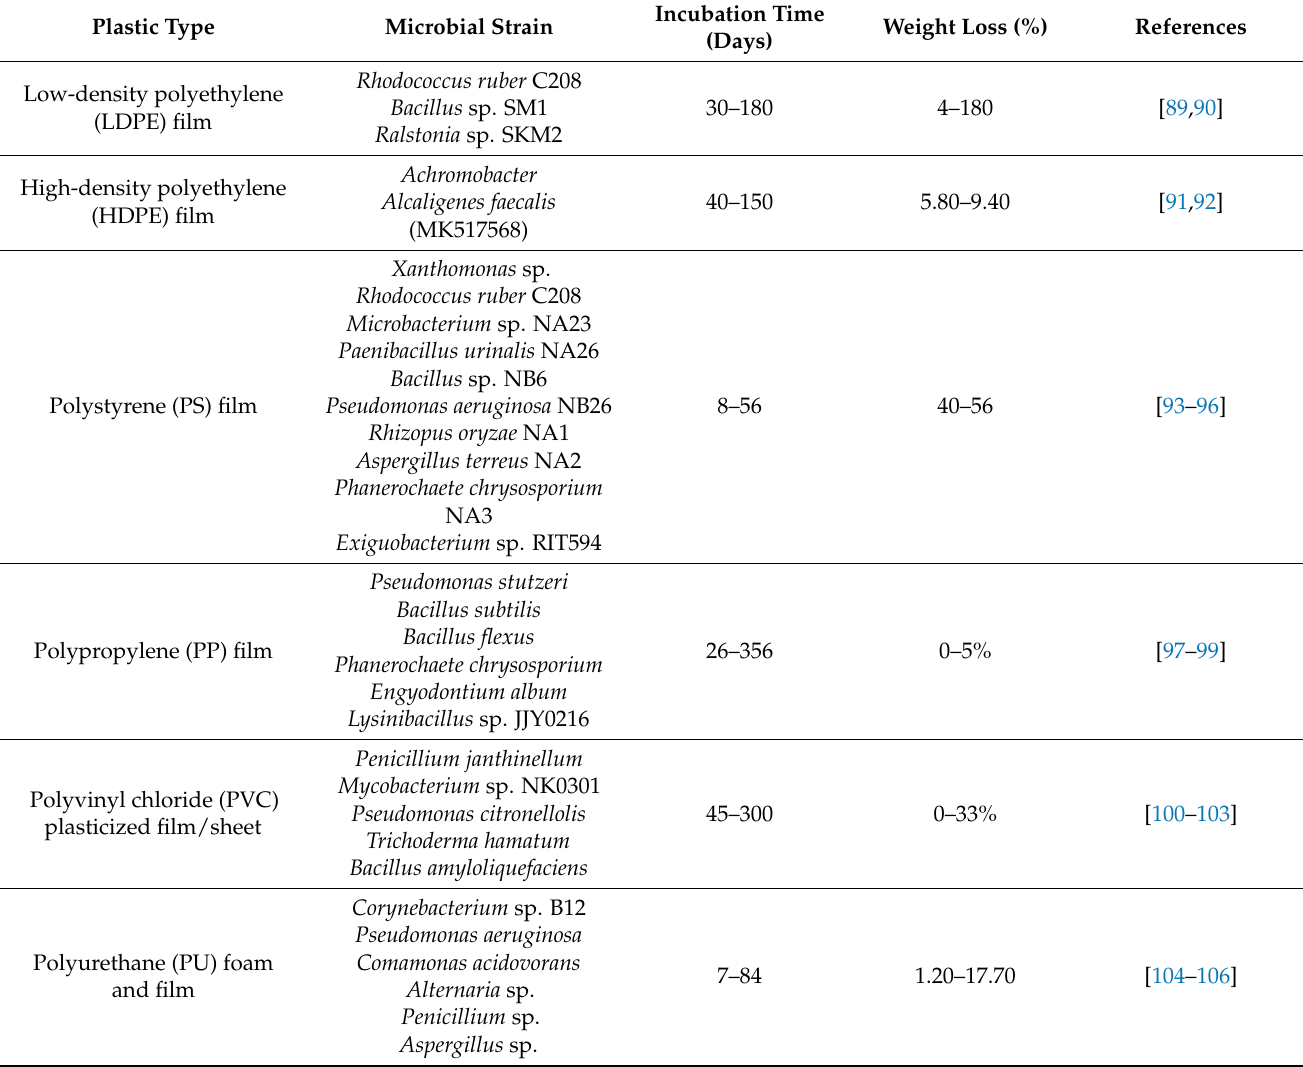
Table 1. Degradation of commonly used synthetic plastics by selected microorganisms in